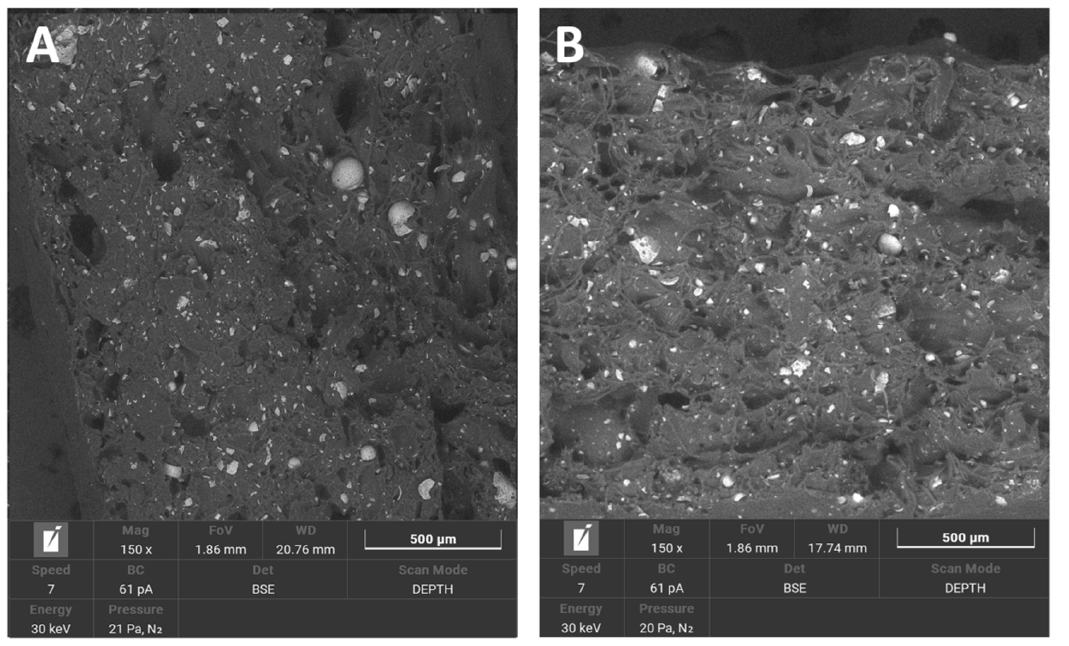
Figure 15. SEM micrographs used to compare breakthroughs of ( A ) PA12_CS _NS and ( B ) PA12_CS_S